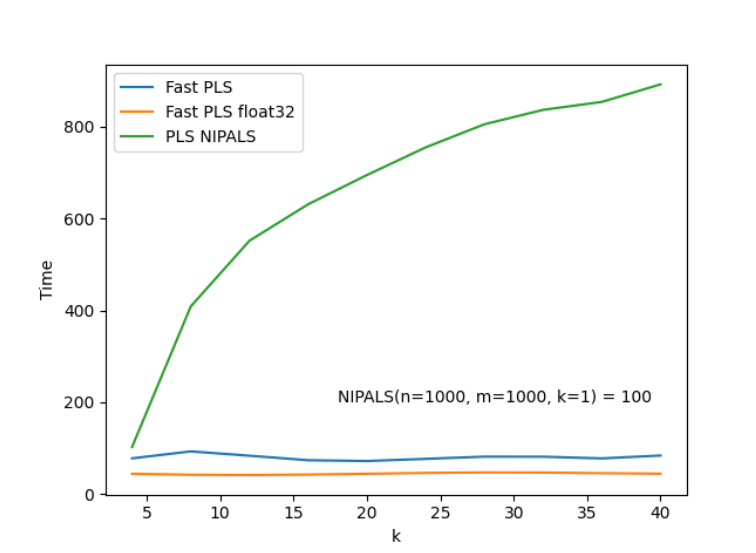
Figure 5. Effect of k on training speed with ( n = 1000, m = 1000 )